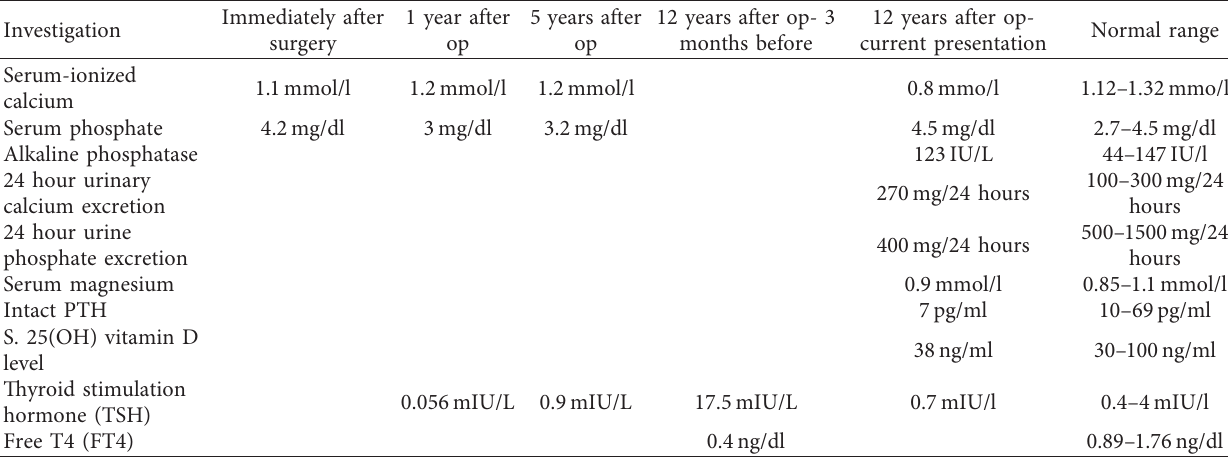
Table 2: Summary of investigations of case 2.